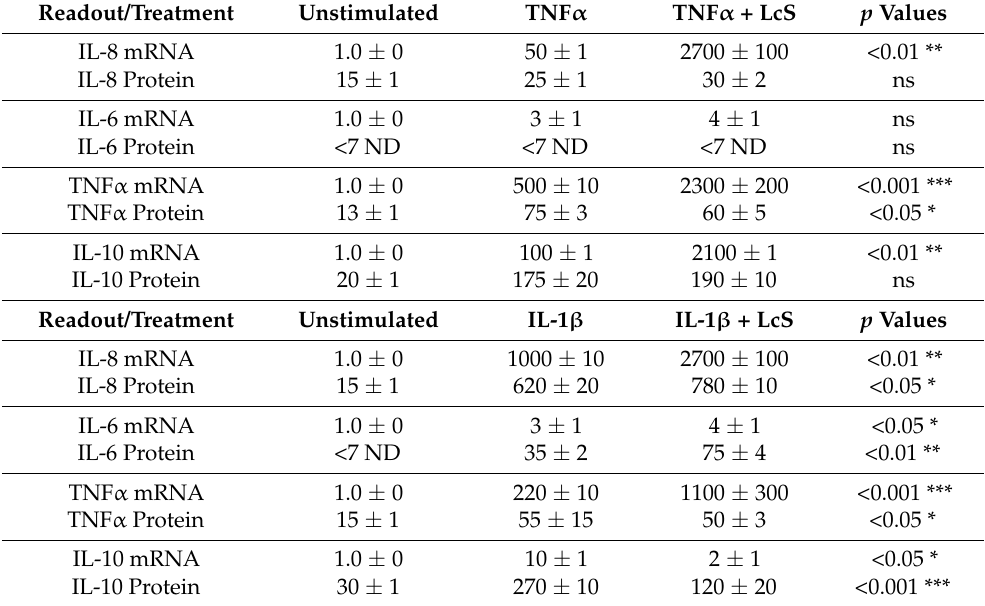
Table 2. Heat-killed LcS differentially modulates epithelial cell cytokines induced by the pro- inflammatory cytokines, TNF α and IL-1 β . Readout/Treatment Unstimulated TNF α TNF α + LcS p Values IL-8 mRNA IL-8